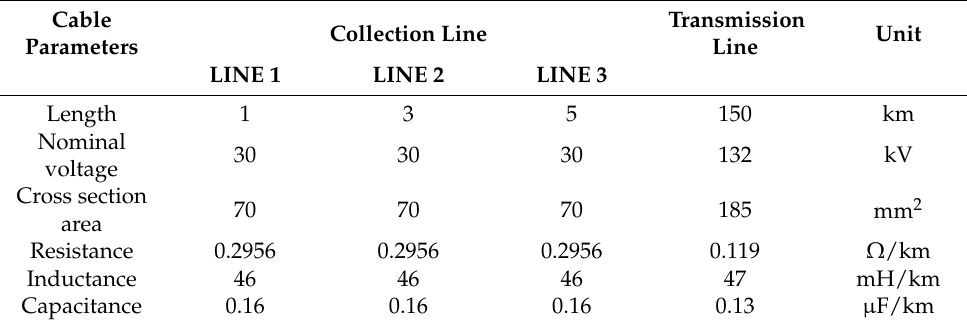
Table 3. ABB XLPE cables